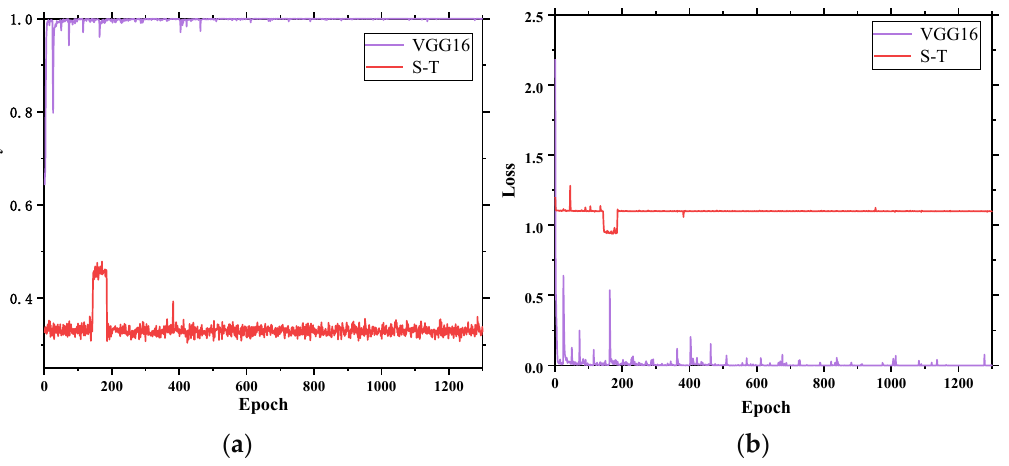
Figure 11. Single-channel VGG16 and S-T models evaluation metrics under learning rate expands 10 times. ( a ) Accuracy comparison of VGG16 and S-T models; ( b ) Loss comparison of VGG16 and S-T models.